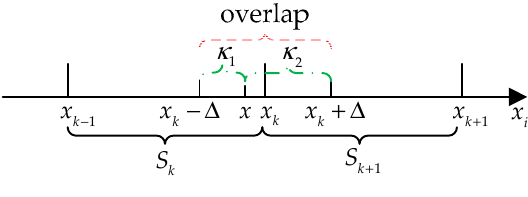
Figure 1. Schematic diagram of the overlap calculation.